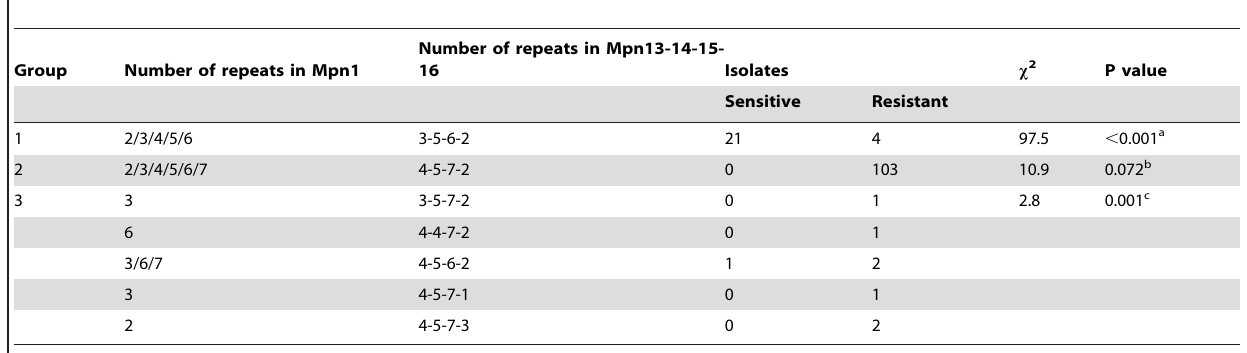
Table 3. Comparison of macrolide resistant rate among M. pneumoniae clinical isolates with different VNTRs.